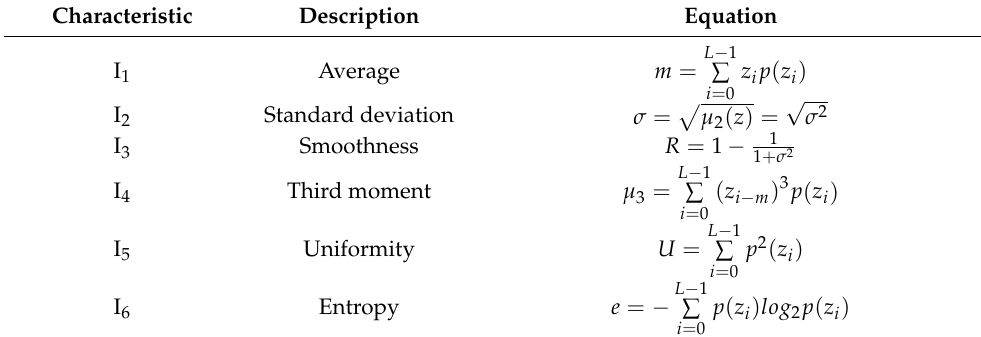
Table 1. Statistical texture attributes.